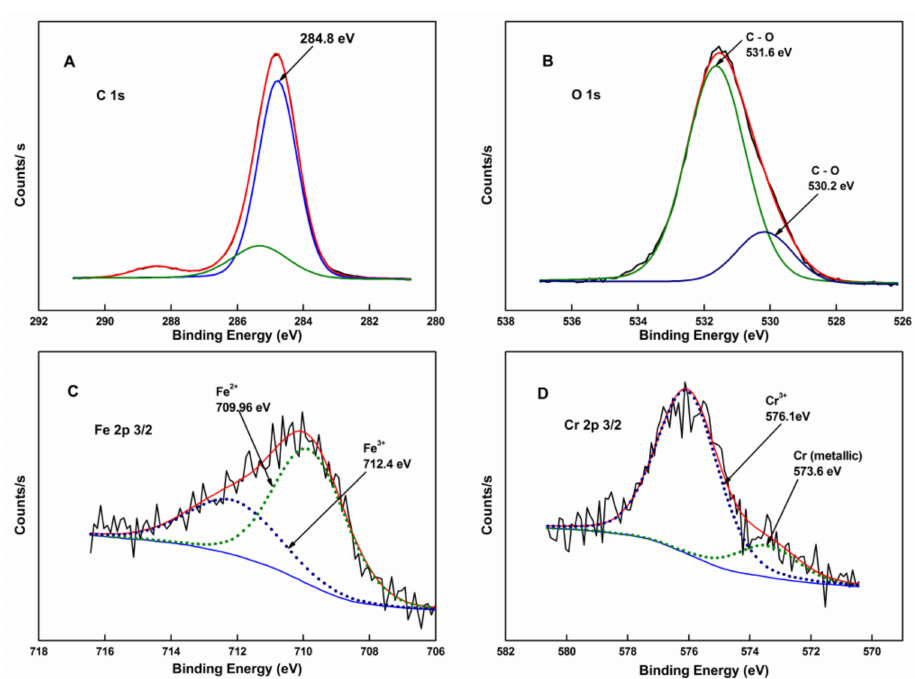
Figure 5. The XPS high-resolution spectrum from the fractured surface of coated sample ( A ) C 1s,